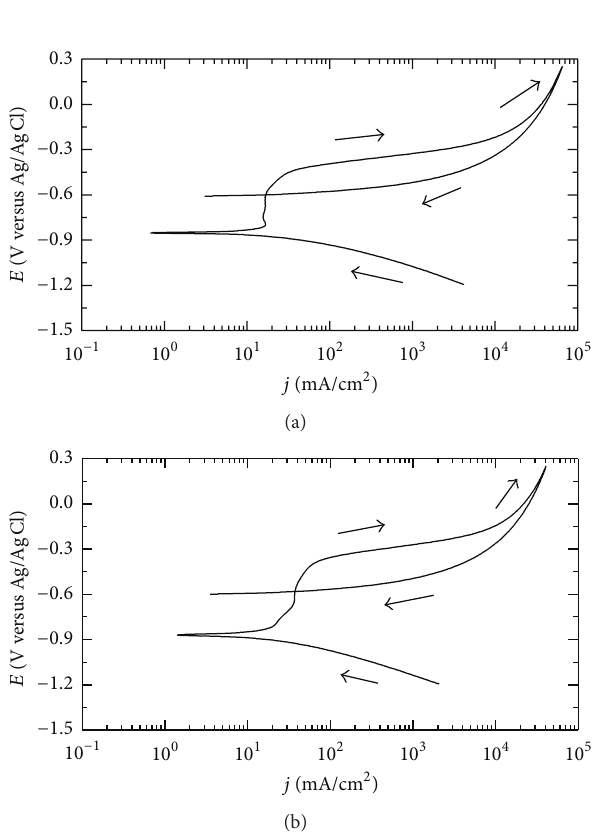
Figure 6: Cyclic potentiodynamic polarization curves obtained for API X70 pipeline steel after its immersion for (a) 1h and (b) 20 h in the Arabian Gulf